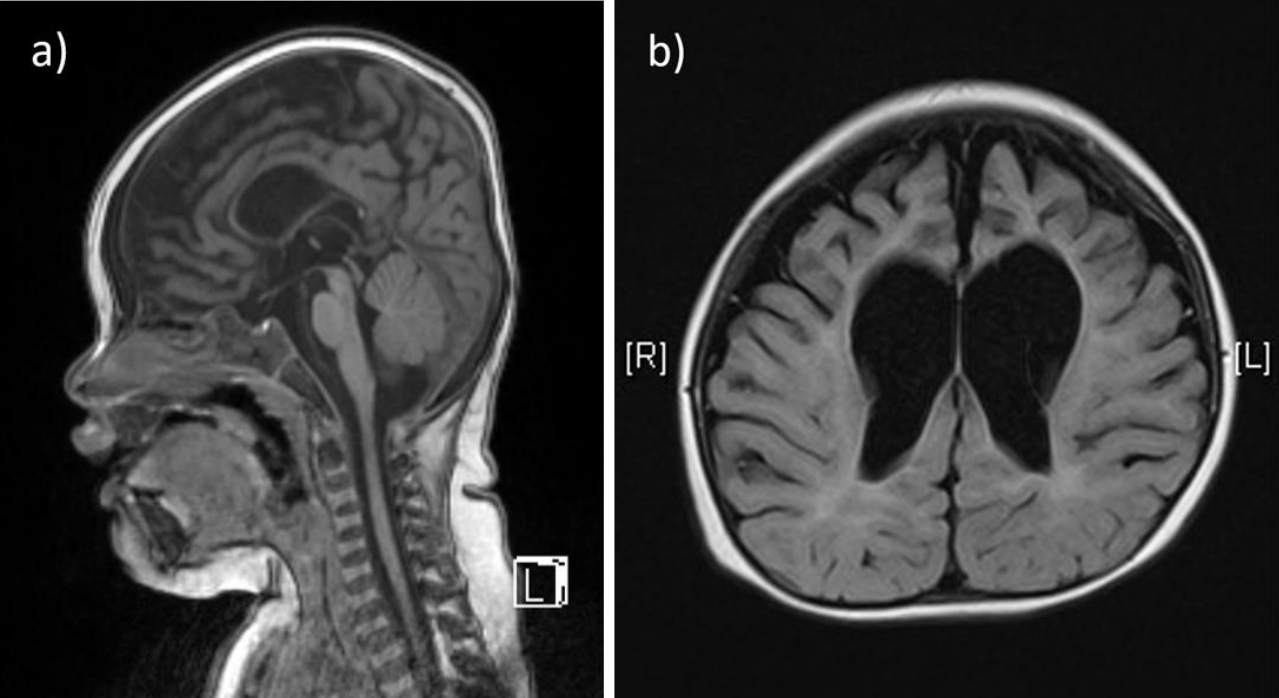
Figure 1. The T1-weighted, sagittal section of brain MRI from patient 1 shows thinning of the corpus callosum (a). The T2-weighted, axial section from the same patient shows diffuse cerebral atrophy involving both gray and white matters, and sulcal widening with prominent enlargement of the ventricular systems, especially at the frontal horns (b).